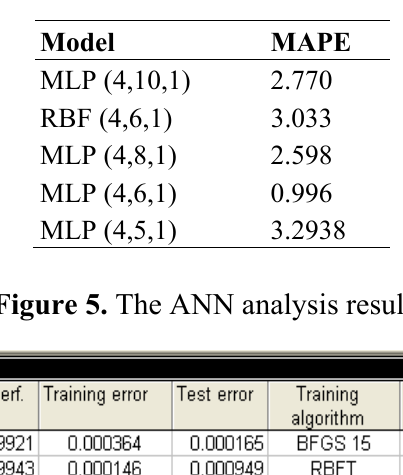
Table 4. Different neural networks and their MAPEs.